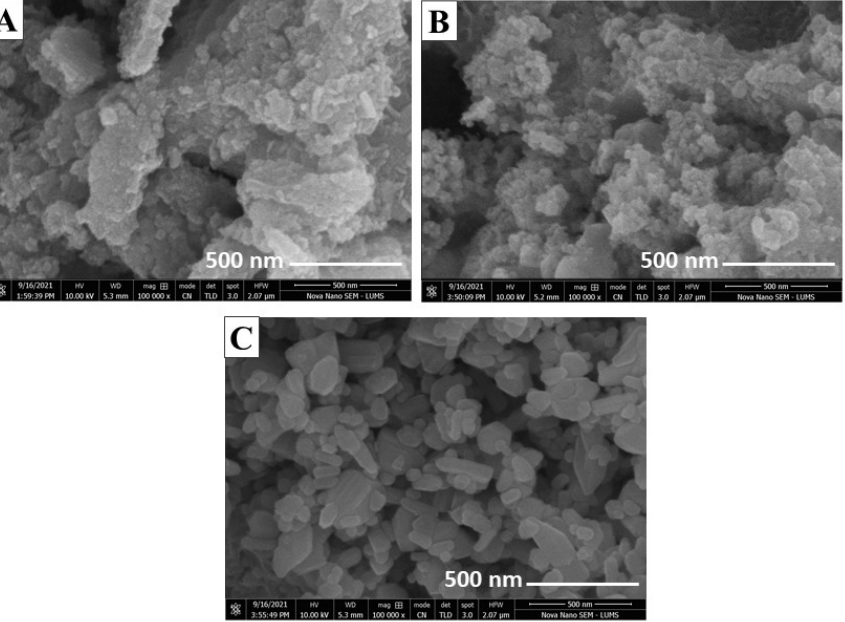
Figure 2. Surface morphology of S@Mn(Fe 2 O 4 ) composites: ( A ) SEM of 3%S@Mn(Fe 2 O 4 ), ( B ) SEM of 5%S@Mn(Fe 2 O 4 ), and ( C ) SEM of 7%S@Mn(Fe 2 O 4 ).